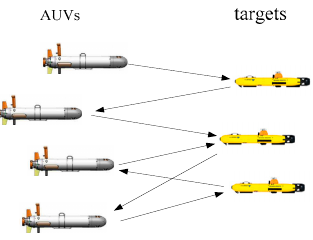
Figure 1. Allocation in the process of underwater cooperative confrontation.